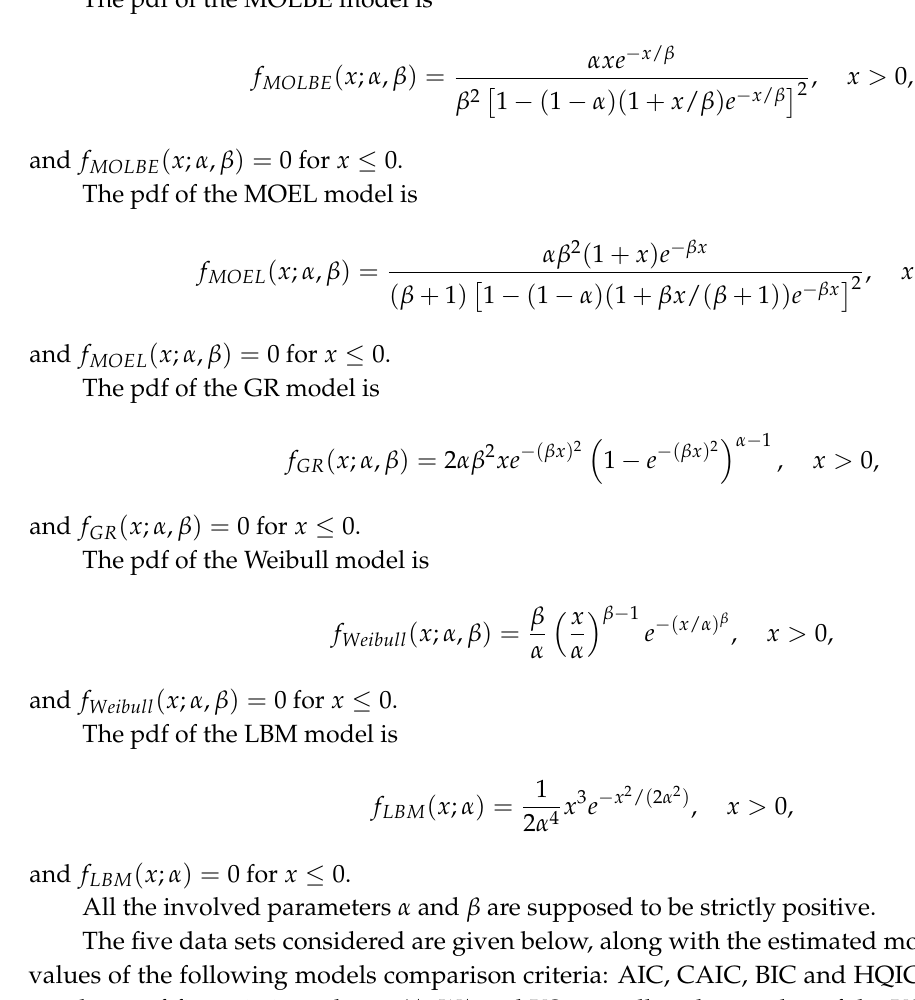
Table 7. Estimates and standard errors (in parentheses) of the parameters for Data set 1.